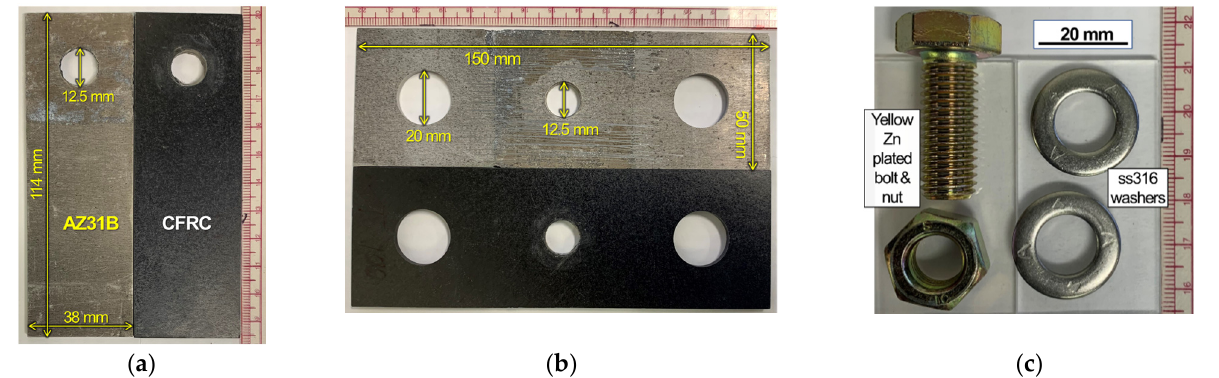
Figure 1. Machined AZ31B and CFRC sheets with 12.5 mm pilot holes for ( a ) lap shear and ( b ) cross-tension joint speci- mens. For bolting in a pilot hole, a steel bolt and a nut with yellow Zn plating, as well as two ss316 washers shown in ( c ) were used.